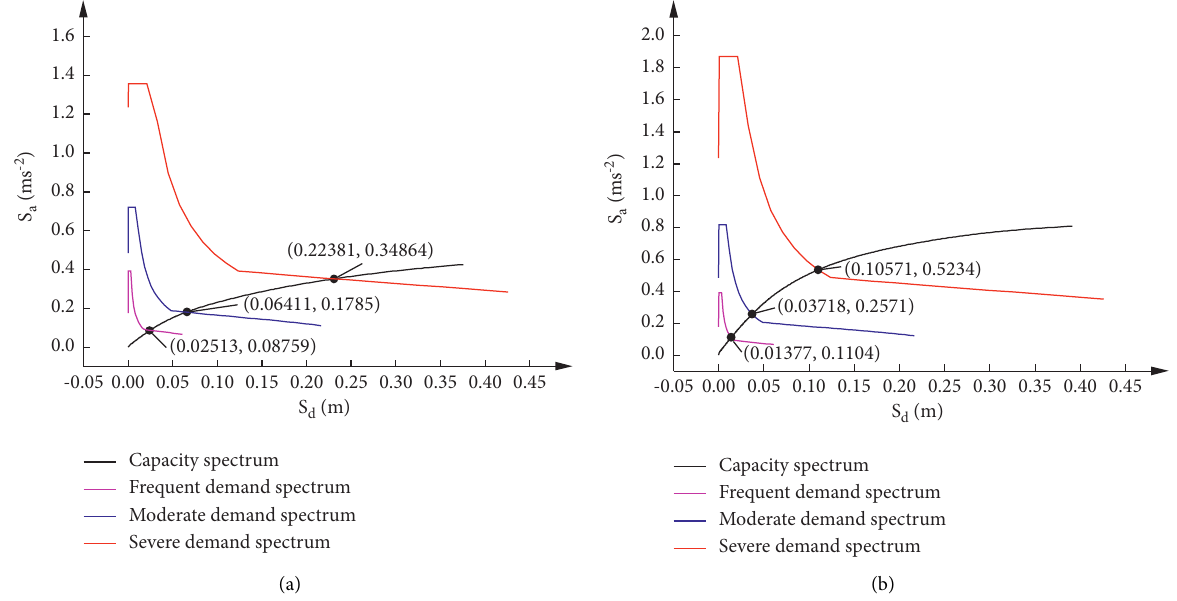
Figure 13: Performance point of RHC shear wall structure. (a) In x direction. (b) In y direction (note: S and S d denotes the spectrum displacement).